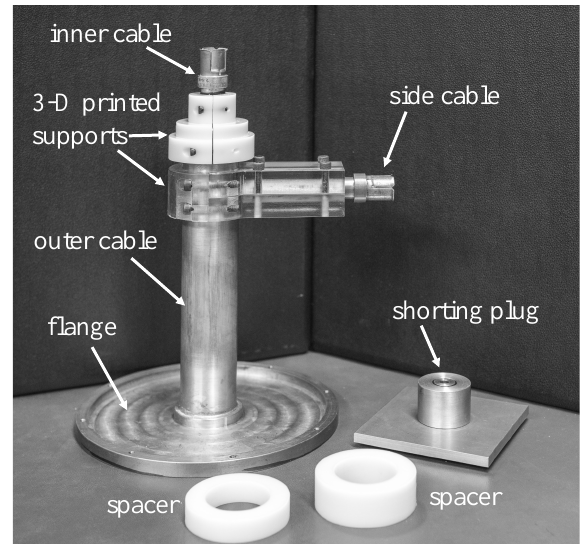
Figure 8. Fabricated triaxial applicator. Also shown are the calibration shorting plug and its